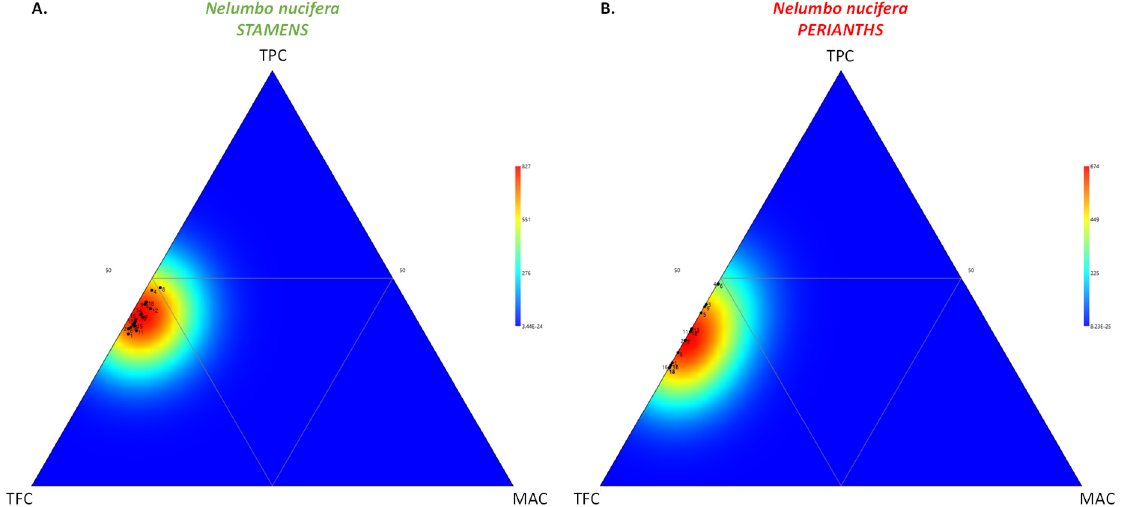
Figure 3. Ternary plot showing the visualization of the relative proportion of TPC, TFC, and TAC within the stamen ( A ) and perianth ( B ) extracts of 18 N. nucifera populations originating from various floristic regions from Thailand.